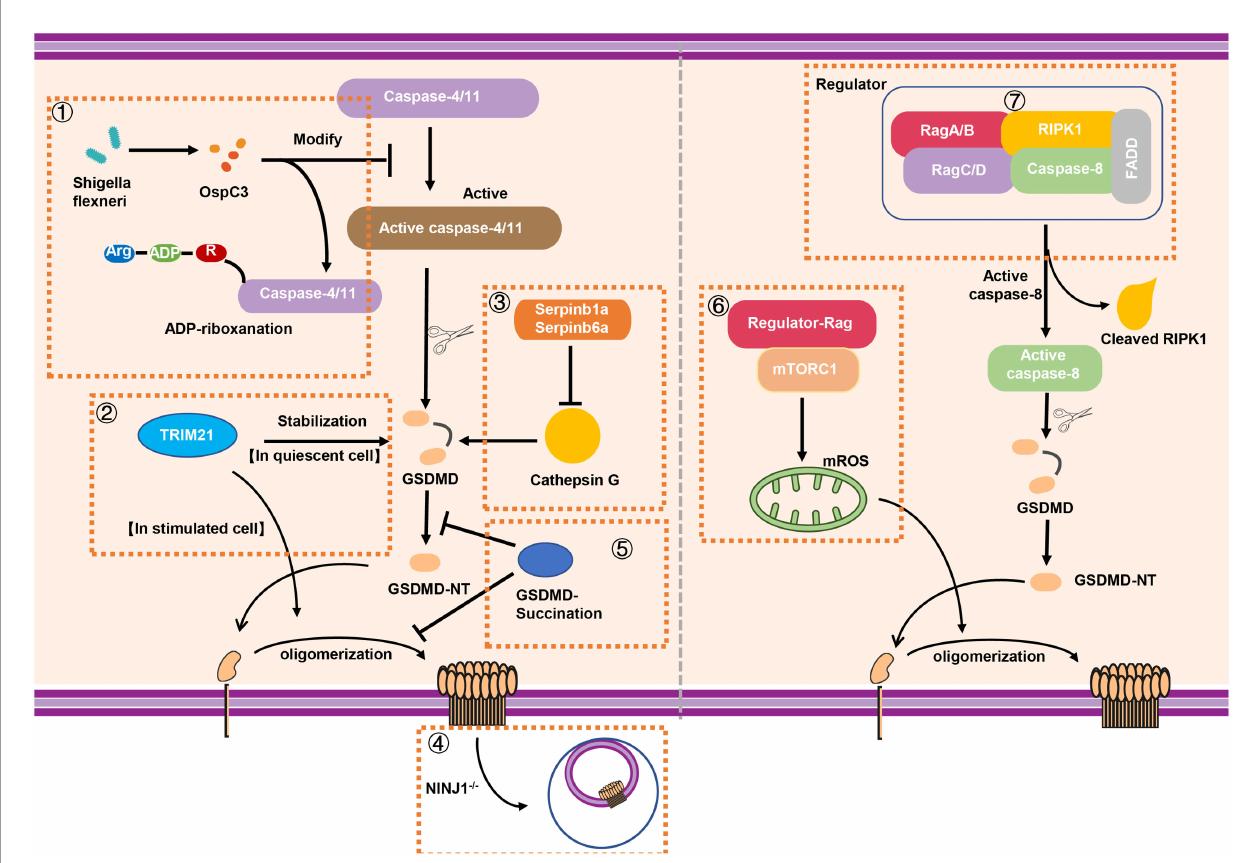
FIGURE 4 | The stabilization and modi fi cation of GSDMD. (1) Shigella fl exneri can secret the effector protein OspC3 to inhibit the function of caspase-4/11 via arginine ADP- riboxanation modi fi cation, leading to the inactivation of GSDMD signaling. (2) A novel binding protein of GSDMD called TRIM21 can stabilize GSDMD in quiescent cell while it promotes the oligomerization of GSDMD-NT for pyroptosis in stimulated cell. (3) In neutrophils, intracellular protease inhibitors Serpinb1a and Serpinb6a suppressed GSDMD- mediated neutrophil pyroptosis by inhibiting Cathepsin G (CATG) which promoting the cleavage of GSDMD. (4) The absence of NINJ1 in macrophage results in impaired plasma membrane rupture, but GSDMD remained the capacity of inducing the formation of membrane pores. (5) GSDMD succination not only prevents its interaction with caspases but also limits its processing, oligomerization and the ability to induce cell death. (6) Rag-Ragulator complex has the capacity to promote oligomerization of GSDMD in pyroptosis via mTORC1-ROS pathway. (7) Rag-Ragulator complex was involved in FADD-RIPK1-Caspase-8 – mediated pyroptosis. RIPK1, Receptor-interacting protein kinase 1; FADD, Fas-associating protein with a novel death domain; mROS, mitochondrial reactive oxygen